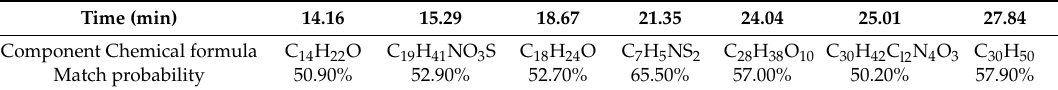
Table 1. Composition-matching statistics of water samples with oil shale heated to 300 ◦ C.